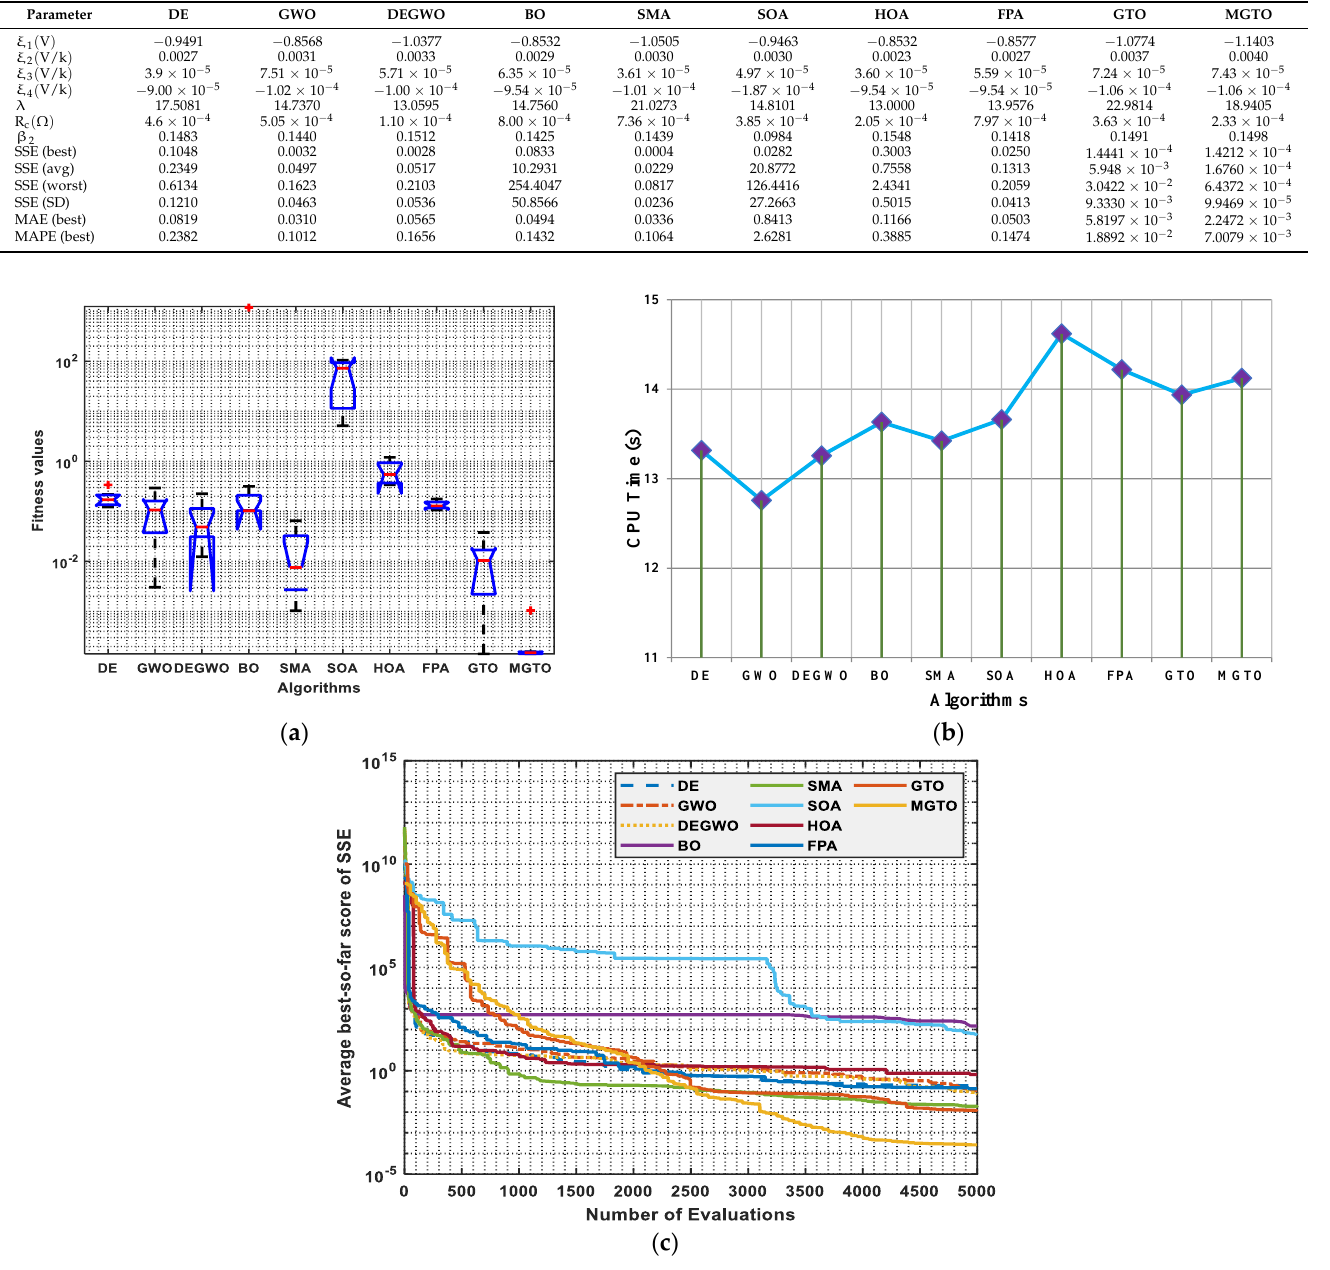
Figure 8. Comparison among algorithms in terms of five-number summary (boxplot), convergence speed, and CPU time on test case 3: ( a ) boxplot of the obtained outcomes, ( b ) CPU time, ( c ) convergence curve. Table 8. Comparison under Wilcoxon rank-sum test using test case